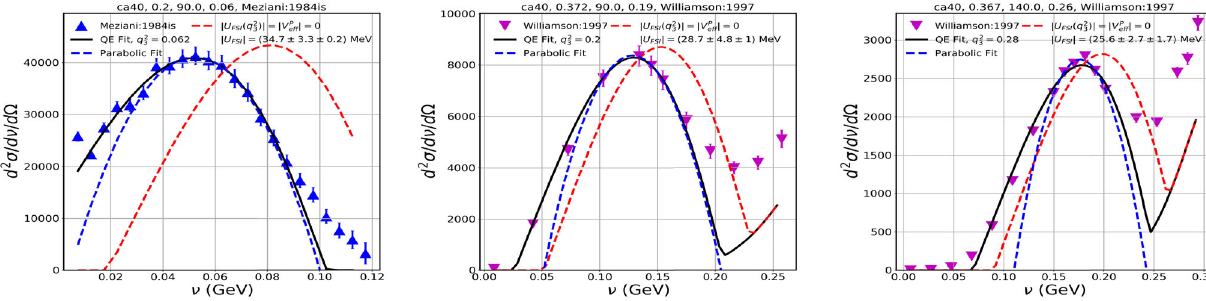
Ca ( k P = 0.251 GeV) QE differential cross sections F 20